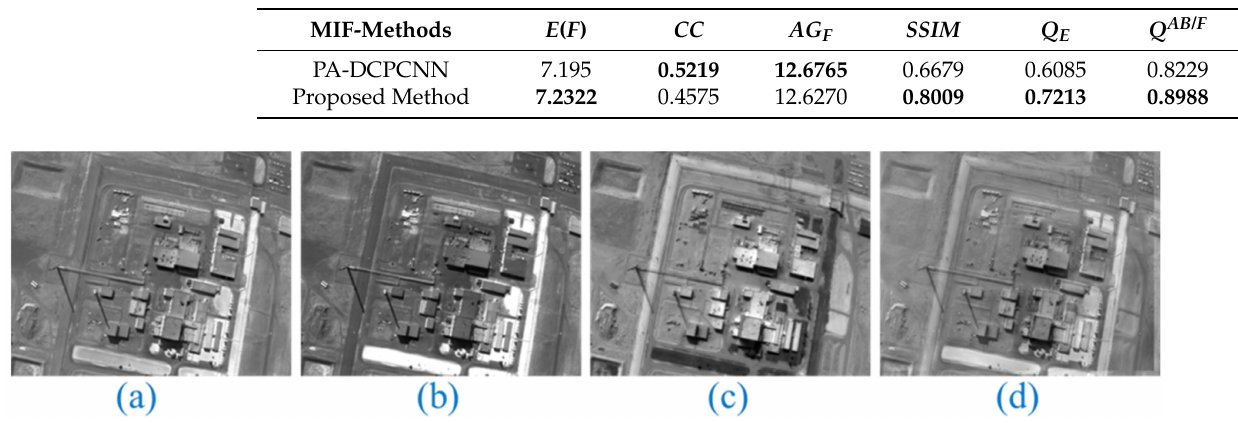
Table 14. The results and comparisons for remote sensing image ([20]).